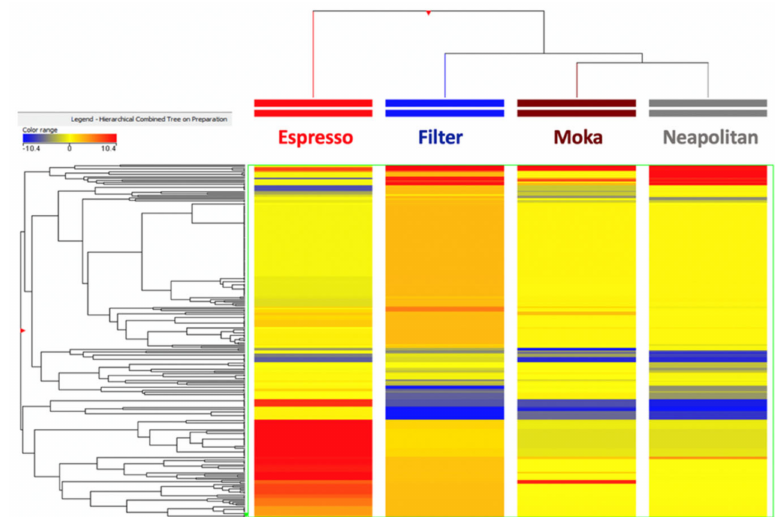
Figure 1. Unsupervised hierarchical cluster analysis (HCA) based on fold-change heat map (similarity: Euclidean; linkage rule: ward) for the different coffee samples included in the different extraction category (i.e., Espresso, Filter, Moka, and Neapolitan).